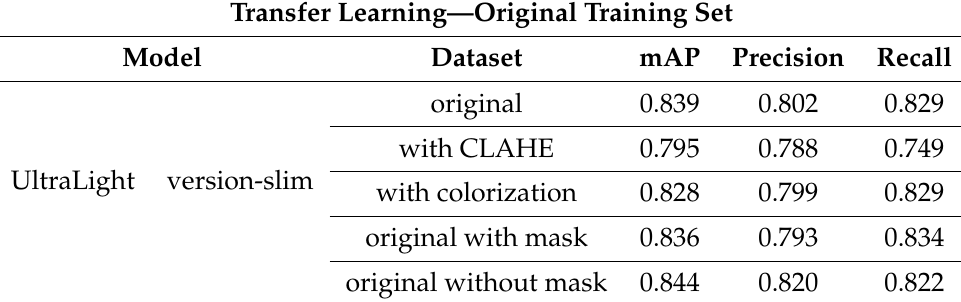
Table 4. Results obtained for testing model trained on own original